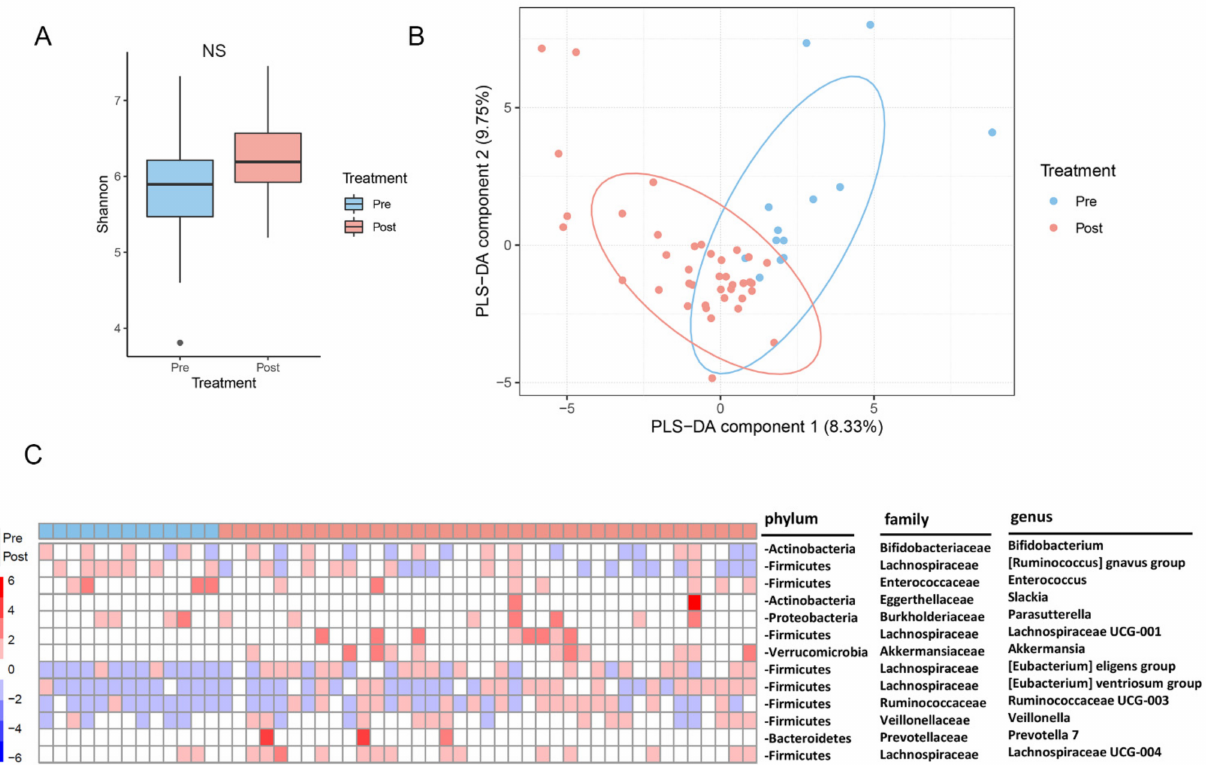
Figure 1. Changes in the gut microbiota after metabolic surgery. ( A ) Pre-surgery and post-surgery alpha diversity. Shannon’s index between pre-surgery and post-surgery is shown ( p = 0.0987). While there is a trend towards a higher alpha diversity post-surgically, this was not statistically significant. NS, not significant. ( B ) Pre-surgery and post-surgery beta diversity. Pre-surgical and post-surgical partial least squares discriminant analysis (PLS-DA) score plot is shown. Differential pre-surgical and post-surgical clustering is observed. ( C ) Differential bacterial composition after metabolic surgery. The bacterial taxa between pre-surgery and post-surgery are compared by using DEseq2. Heat map (converting to z-scores of the rows) of the differential bacterial genus abundance after surgery are shown (adjusted p < 0.05, |log2 fold change| >